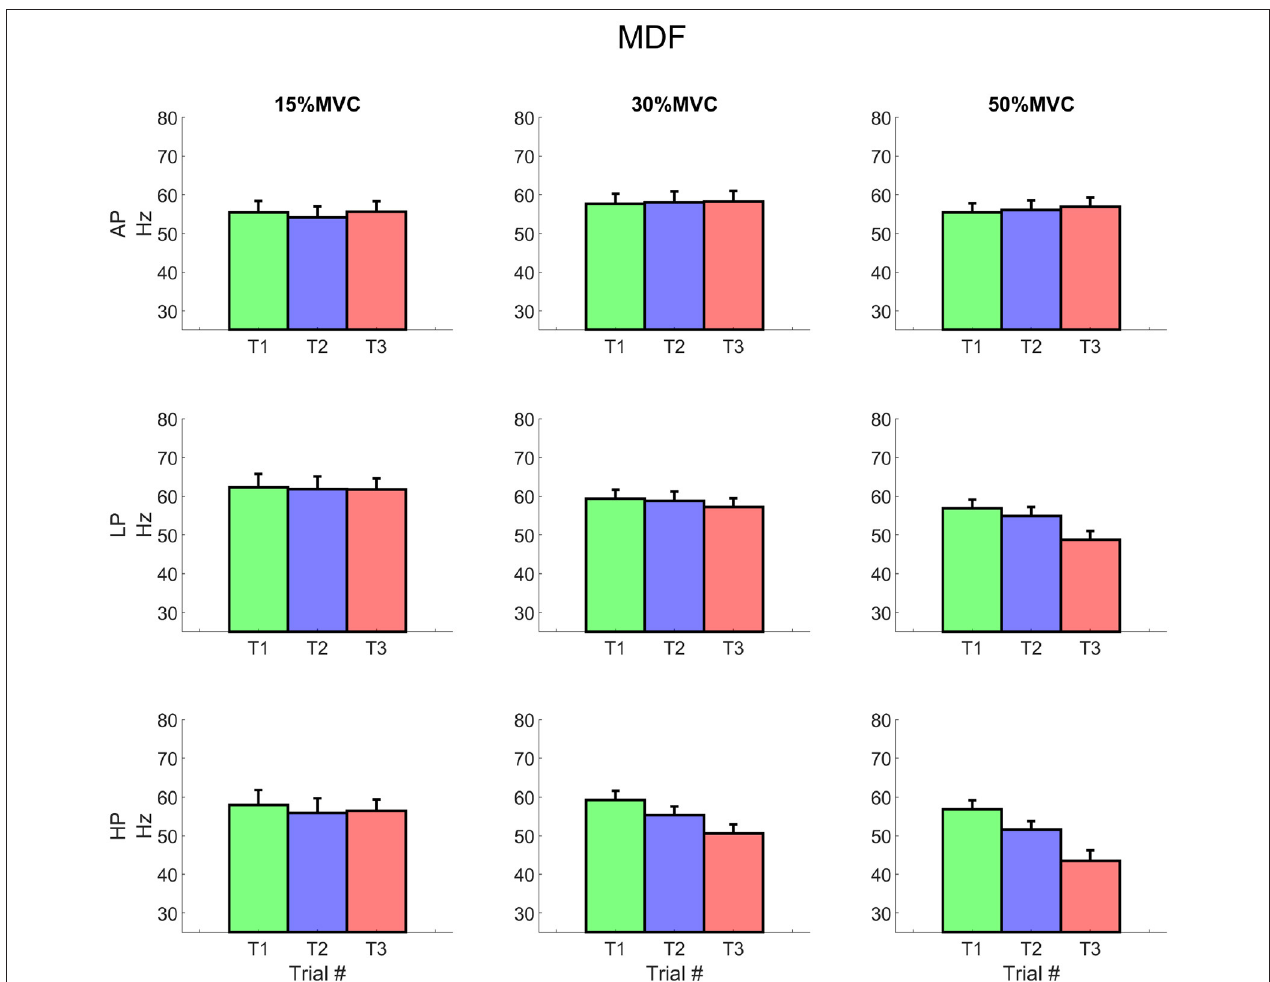
FIGURE 7 | EMG median frequency for each condition. The values represent the average of all included channels across the matrix. It is worth noting the decrement of the variable at 30% MVC for LP3 and at 50% MVC for both LP and HP respectively, starting from Trial 2. Rows represent different levels of pressure, columns, different levels of torque. The data is represented as average and standard error across all the subjects for the three repetitions of the task. Trial 1 is represented in green, trial 2, in blue, and trial 3, in